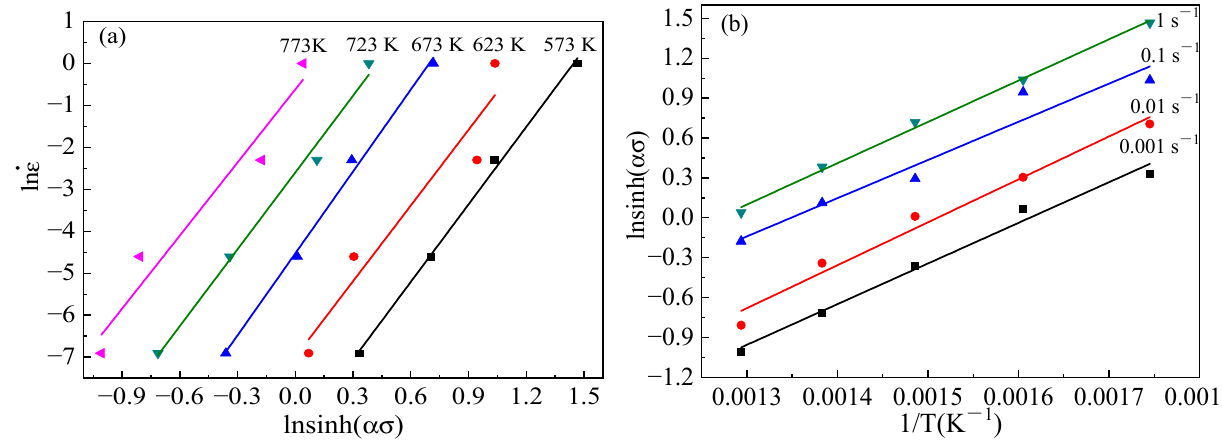
Figure 7. Relationship of ( a ) for B 4 C p /6063Al.